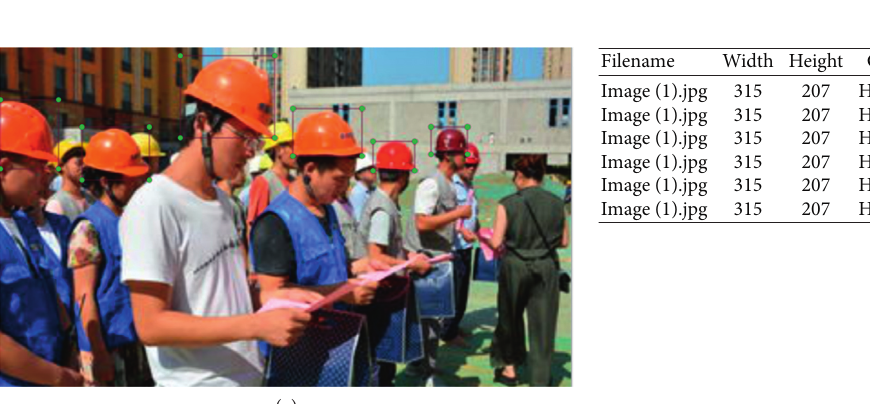
Figure 4: Image dataset.